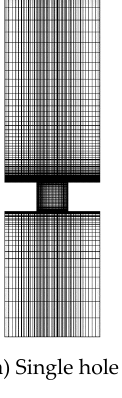
Figure 5. CFD meshes in the yz plane. Processes 2020 , 8 , x FOR PEER REVIEW